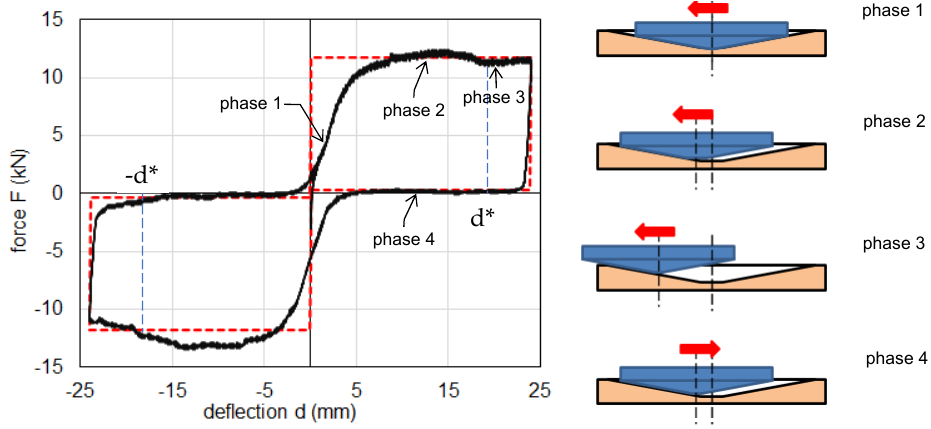
Figure 8. Scaled ground motion acceleration spectra and target spectrum according to the IBC ( ξ = 5%) [33].